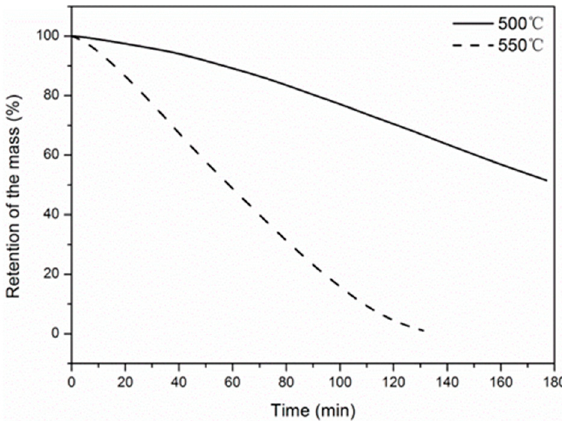
Figure 5. Temperature dependence of the mass evolution of carbon fiber.